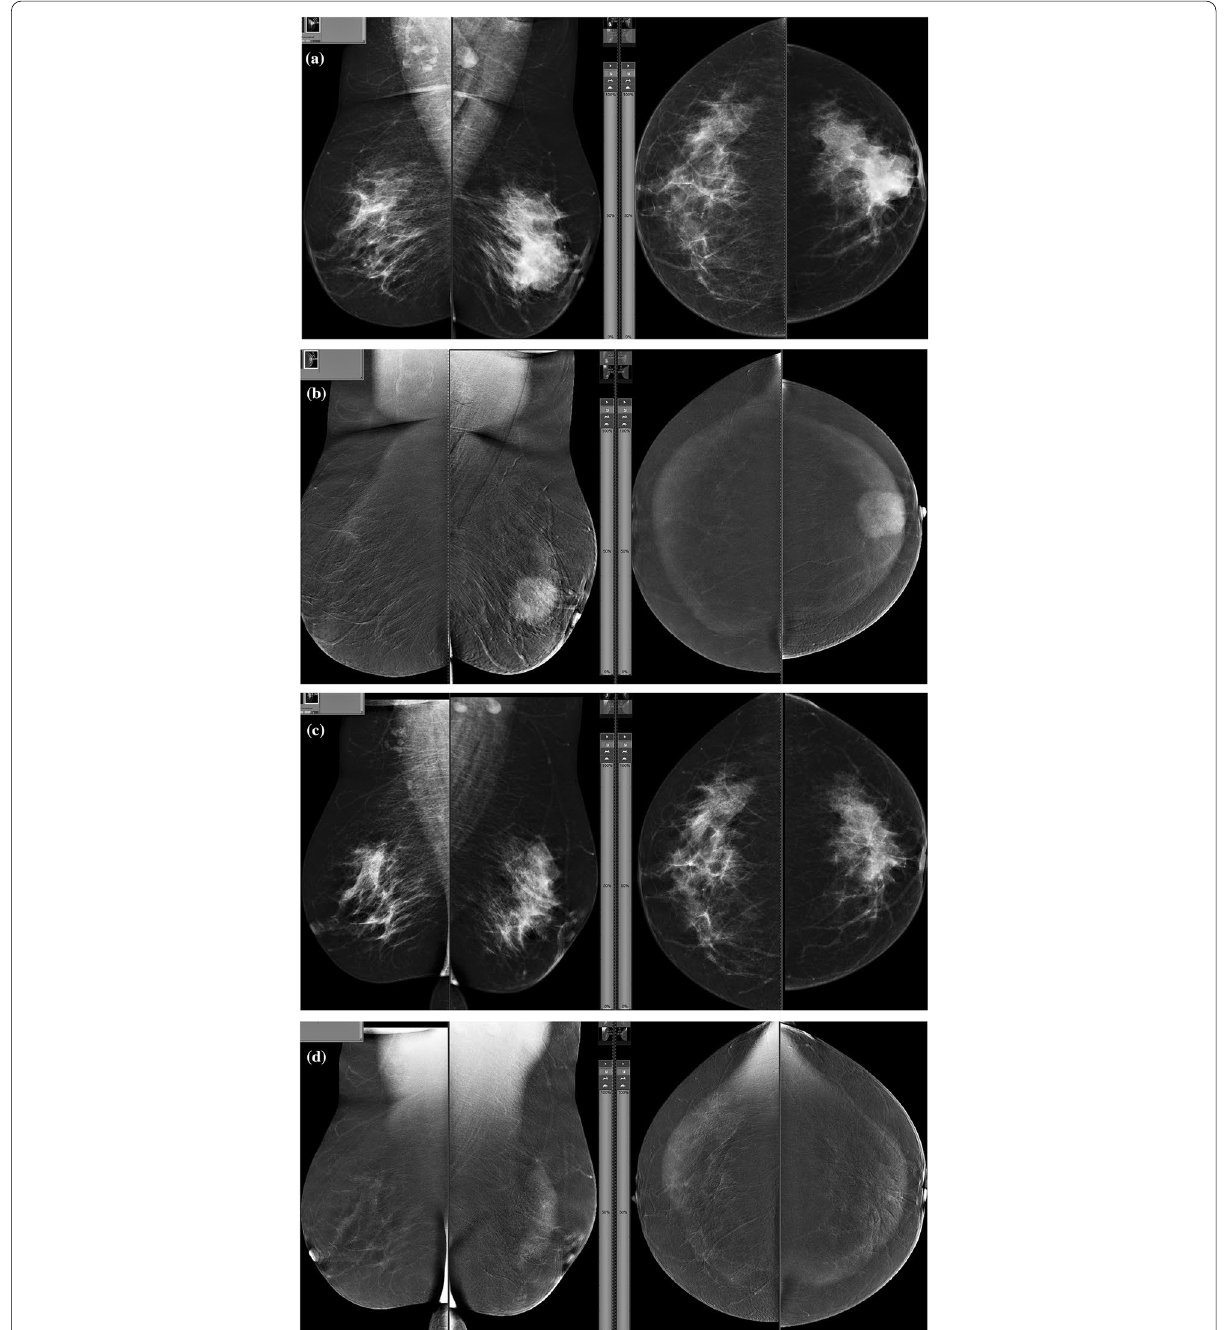
Fig. 4 a Full‑field digital mammography in MLO and CC views and b CESM in MLO and CC views in a 38‑year‑old woman with pathologically proven invasive duct carcinoma grade II showing a left breast dense mass lesion with obscured outlines at the retro‑areolar region showing intense enhancement at the post‑contrast study measuring about 4.1 cm in longest diameter. c Follow‑up full‑field digital mammography in MLO and CC views and CESM in MLO and CC after neoadjuvant chemotherapy showing total resolution of the previously seen mass lesion with no sizable residual enhancing nodule indicating CR. The patient underwent a left modified radical mastectomy. Histopathology assessment revealed CR with no viable tumor cells, free resection margin, and free axillary lymph nodes